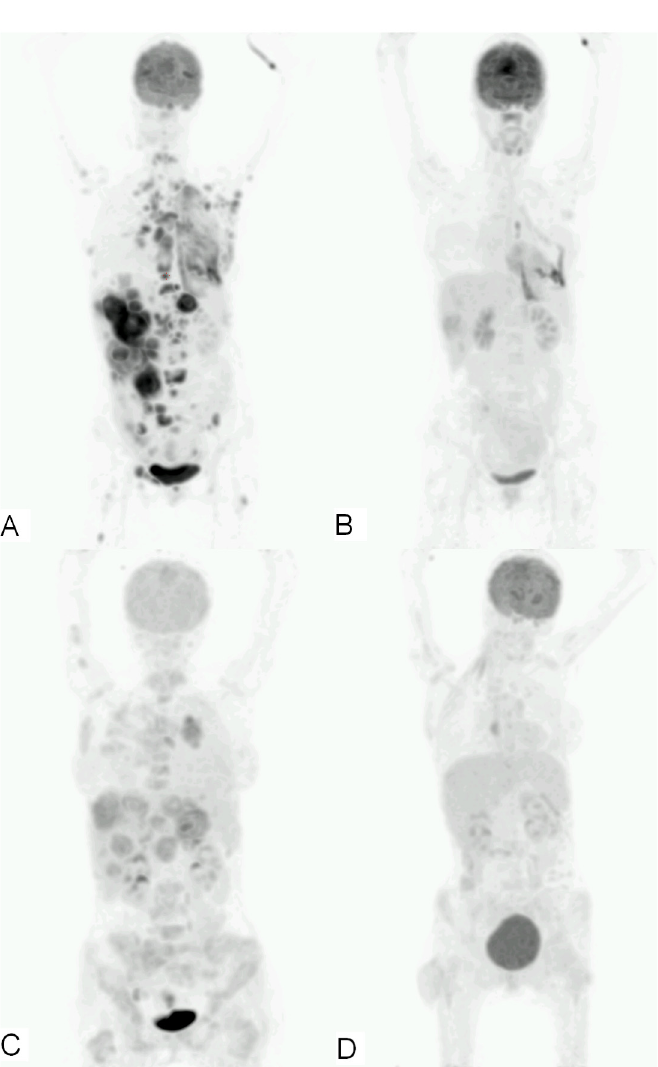
Fig 2. 18 F-FDG maximum intensity projection of patient 2 and 8 prior to (A, B) and after 6 weeks of treatment with crizotinib (C, D). Scale is from 0 – 15 SUV. These images illustrate the clinically dramatic decrease in 18 F-FDG uptake, with both patients having a PMR according to both PERCIST criteria and the EORTC